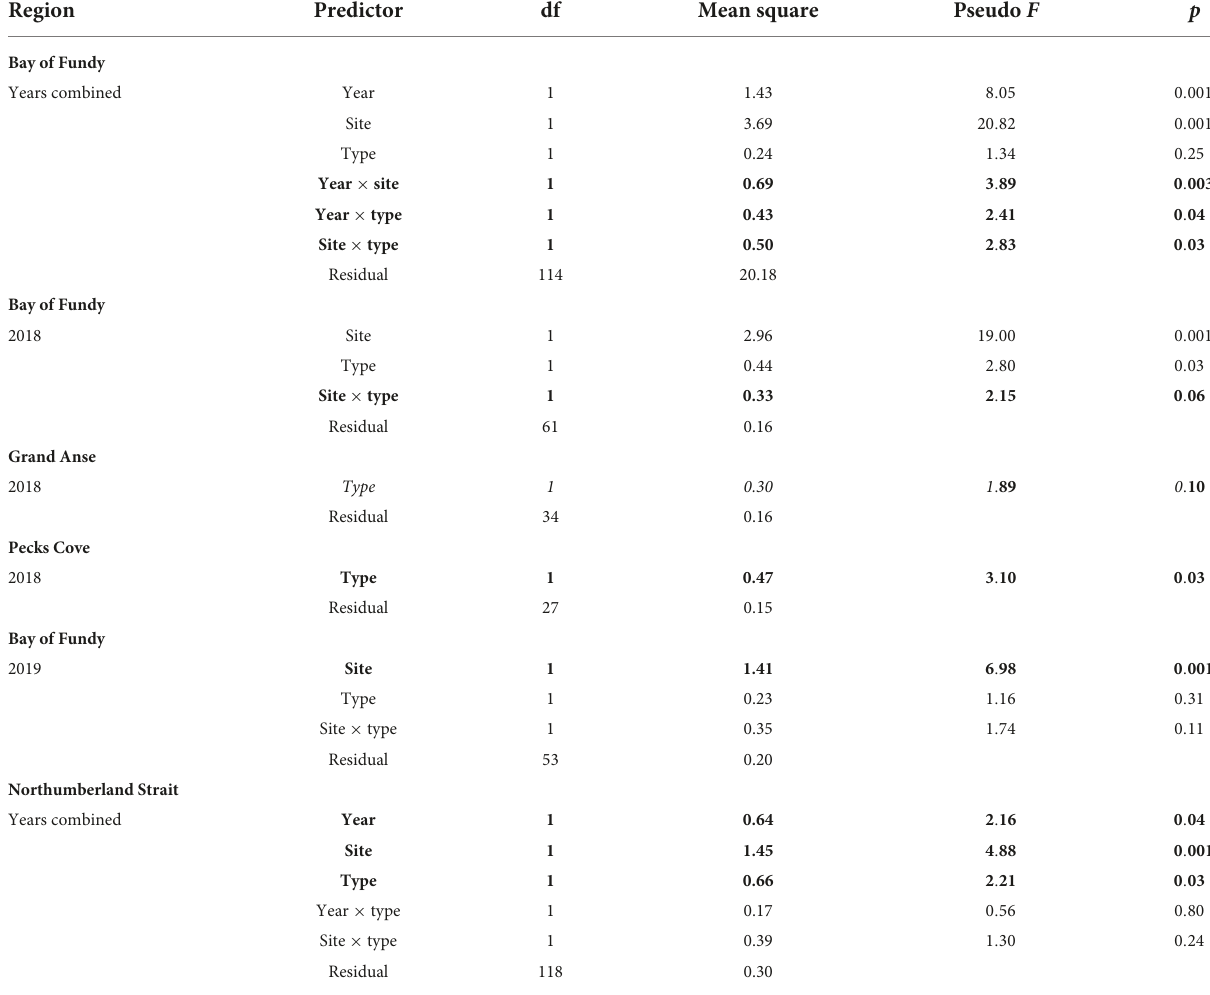
TABLE 2 Permutational multivariate analysis of variances (permutations = 999) of separate models analyzing prey biomass split by region. Region Predictor